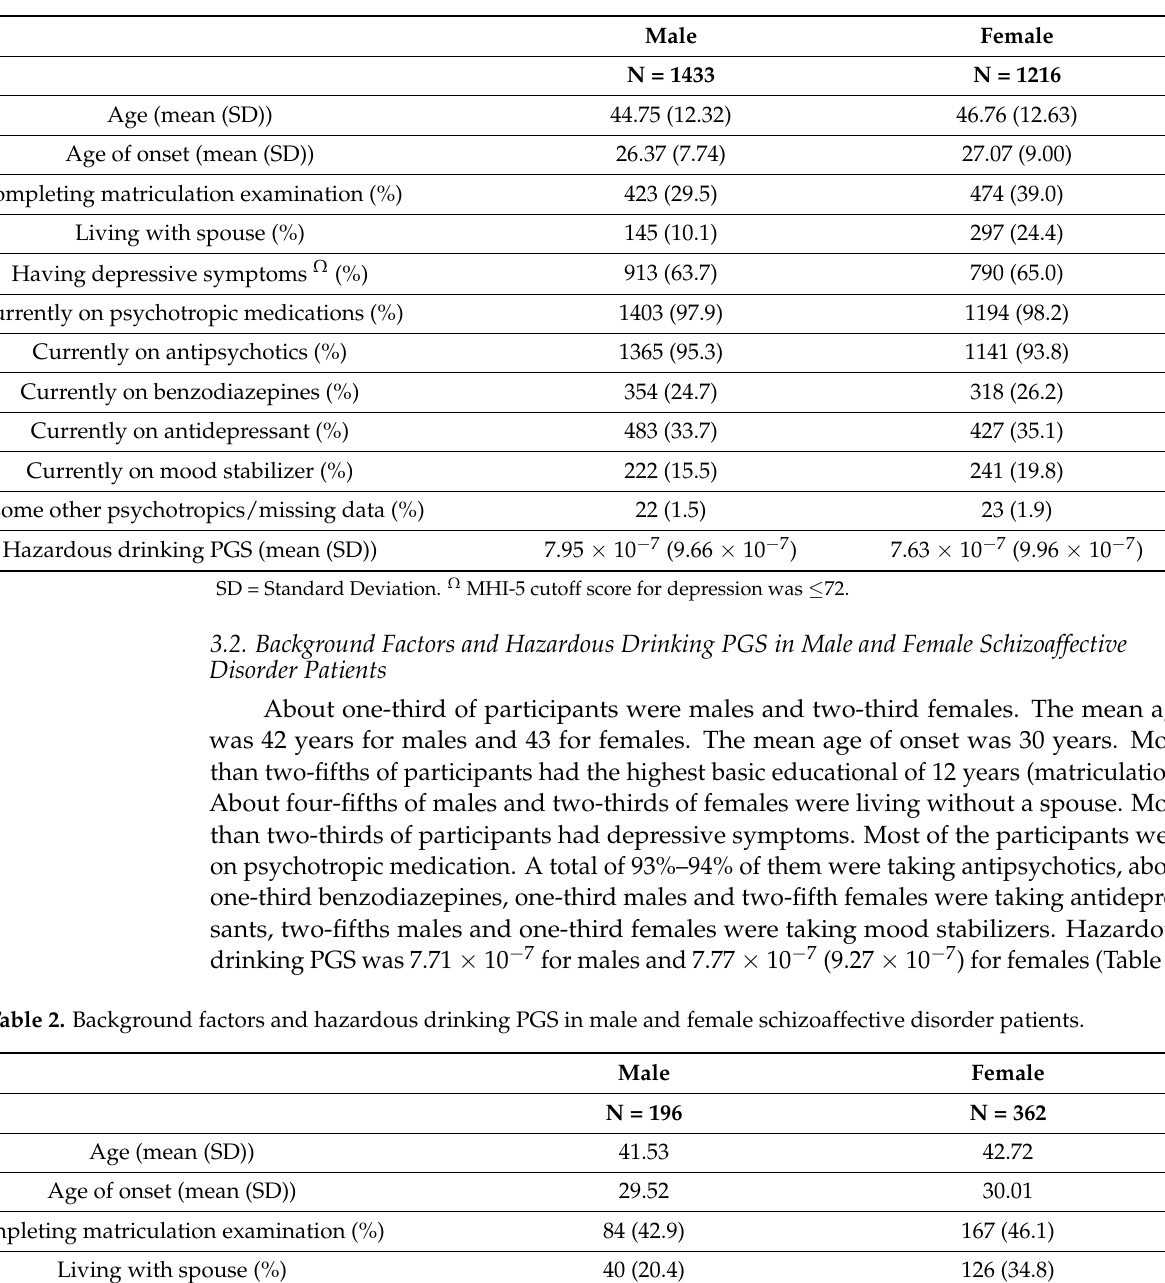
Table 1. Background factors and hazardous drinking PGS in male and female schizophrenia patients.